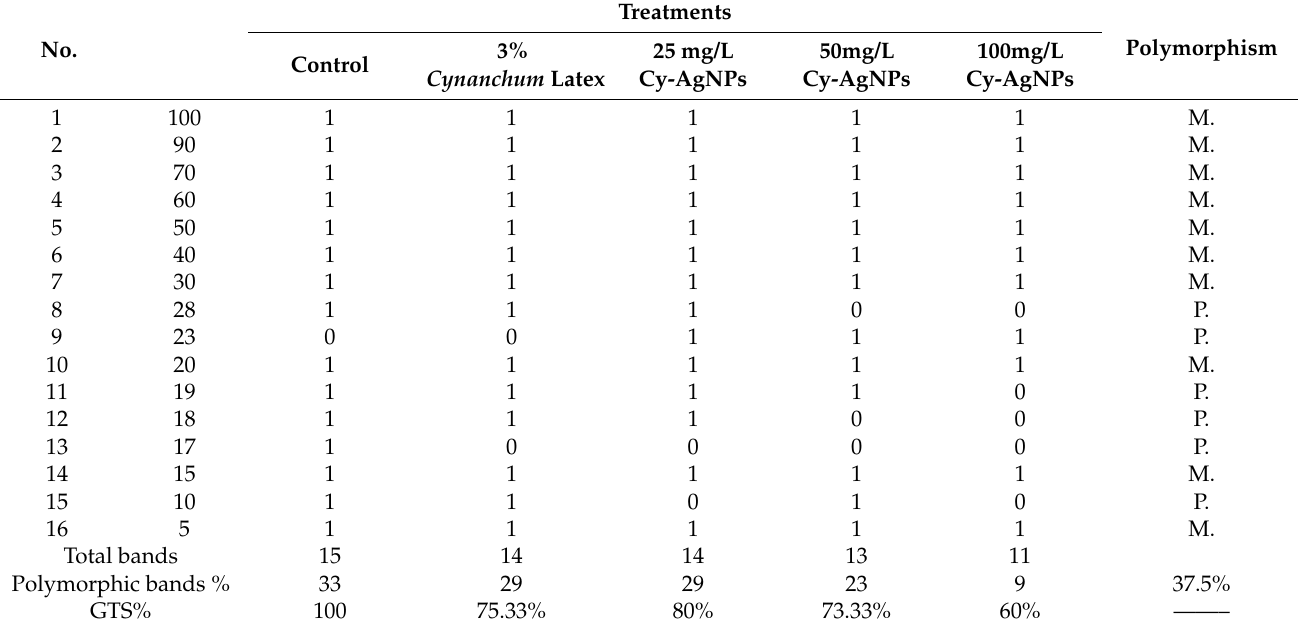
Table 3. Effect of 3% C. acutum crude latex and different concentrations of Cy-AgNPs on pro- tein profiles of V. faba and percentage of genomic template stability (GTS%) of the treated V. faba (P: polymorphic bands and M: monomorphic